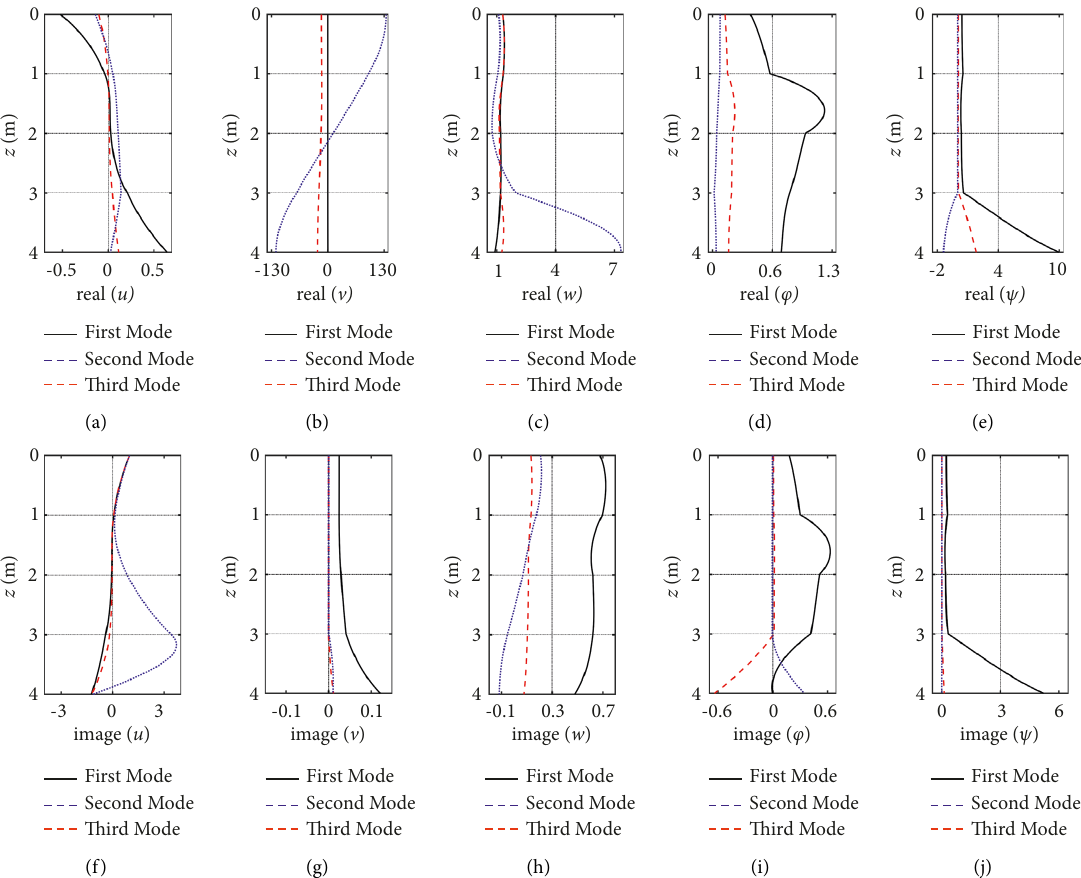
Figure 6: The mechanical displacements, electric and magnetic potentials of guided waves in the four-layered plate for the first three